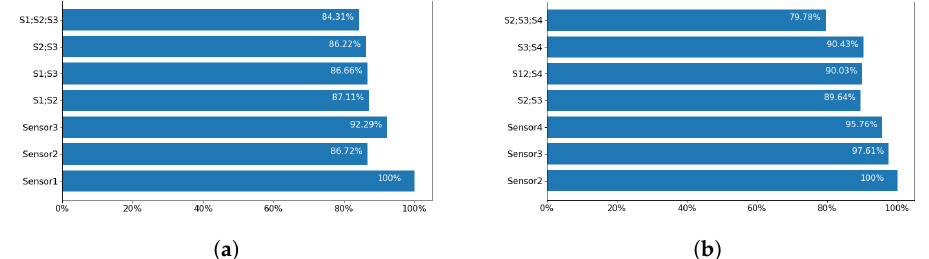
Figure 14. Classification accuracy for individual sensors and combinations of them for ( a ) Coventry- 2018 dataset and ( b ) Infra-ADL2018